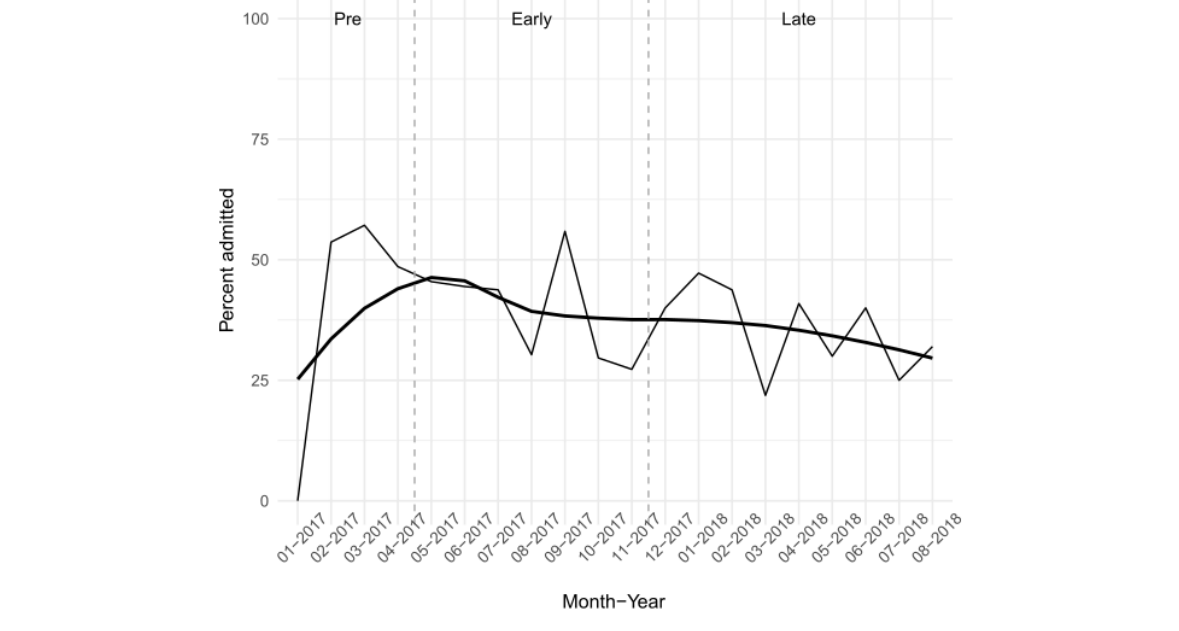
Figure 4. Percentage of transported calls from the intervention community that resulted in a hospital admission. Dashed vertical lines indicate the demarcations between Pre and Early (ie, the start of telemedicine in May 2017) and between Early and Late periods (ie, the start of the new telemedicine use policy in December